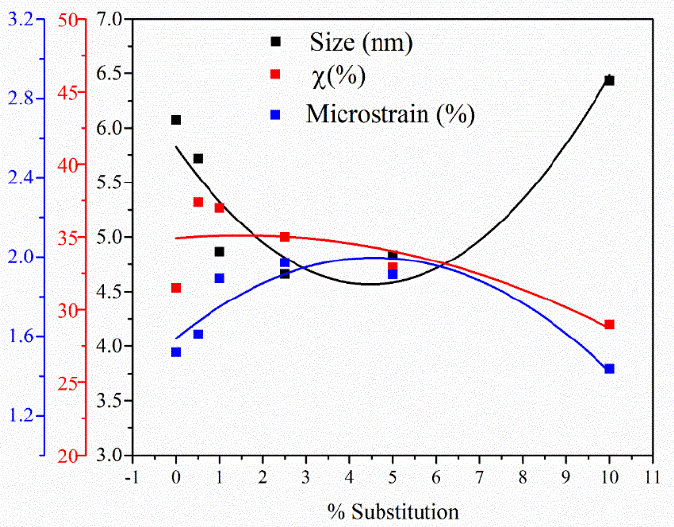
Figure 4. The estimated lattice microstrain, crystallite size and degree of crystallinity for Ca 10 − x Tb x (PO 4 ) 6 (OH) 2.